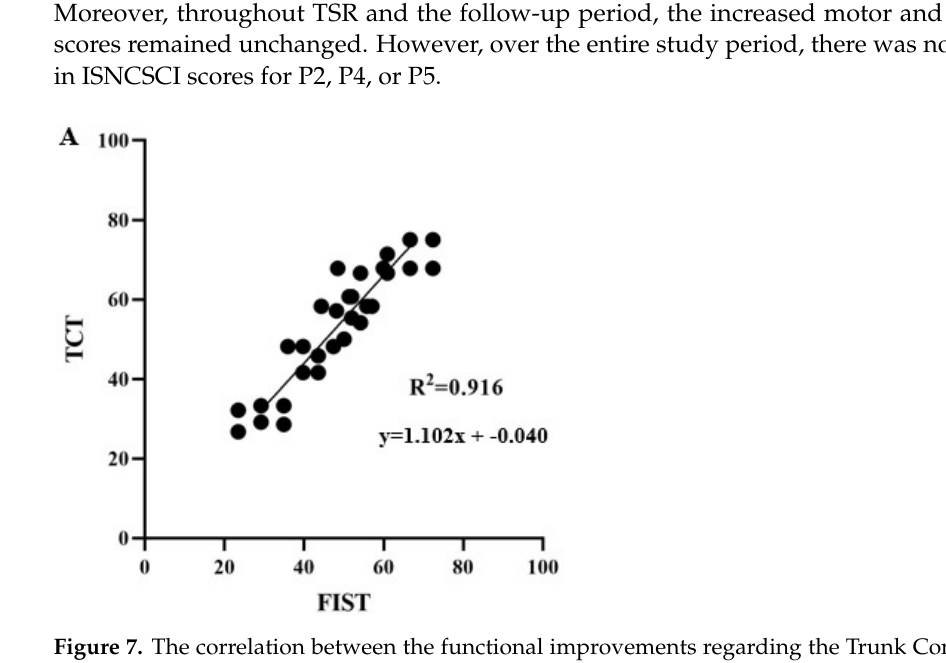
Figure 7. The correlation between the functional improvements regarding the Trunk Control Test (TCT) and Function in Sitting Test (FIST).